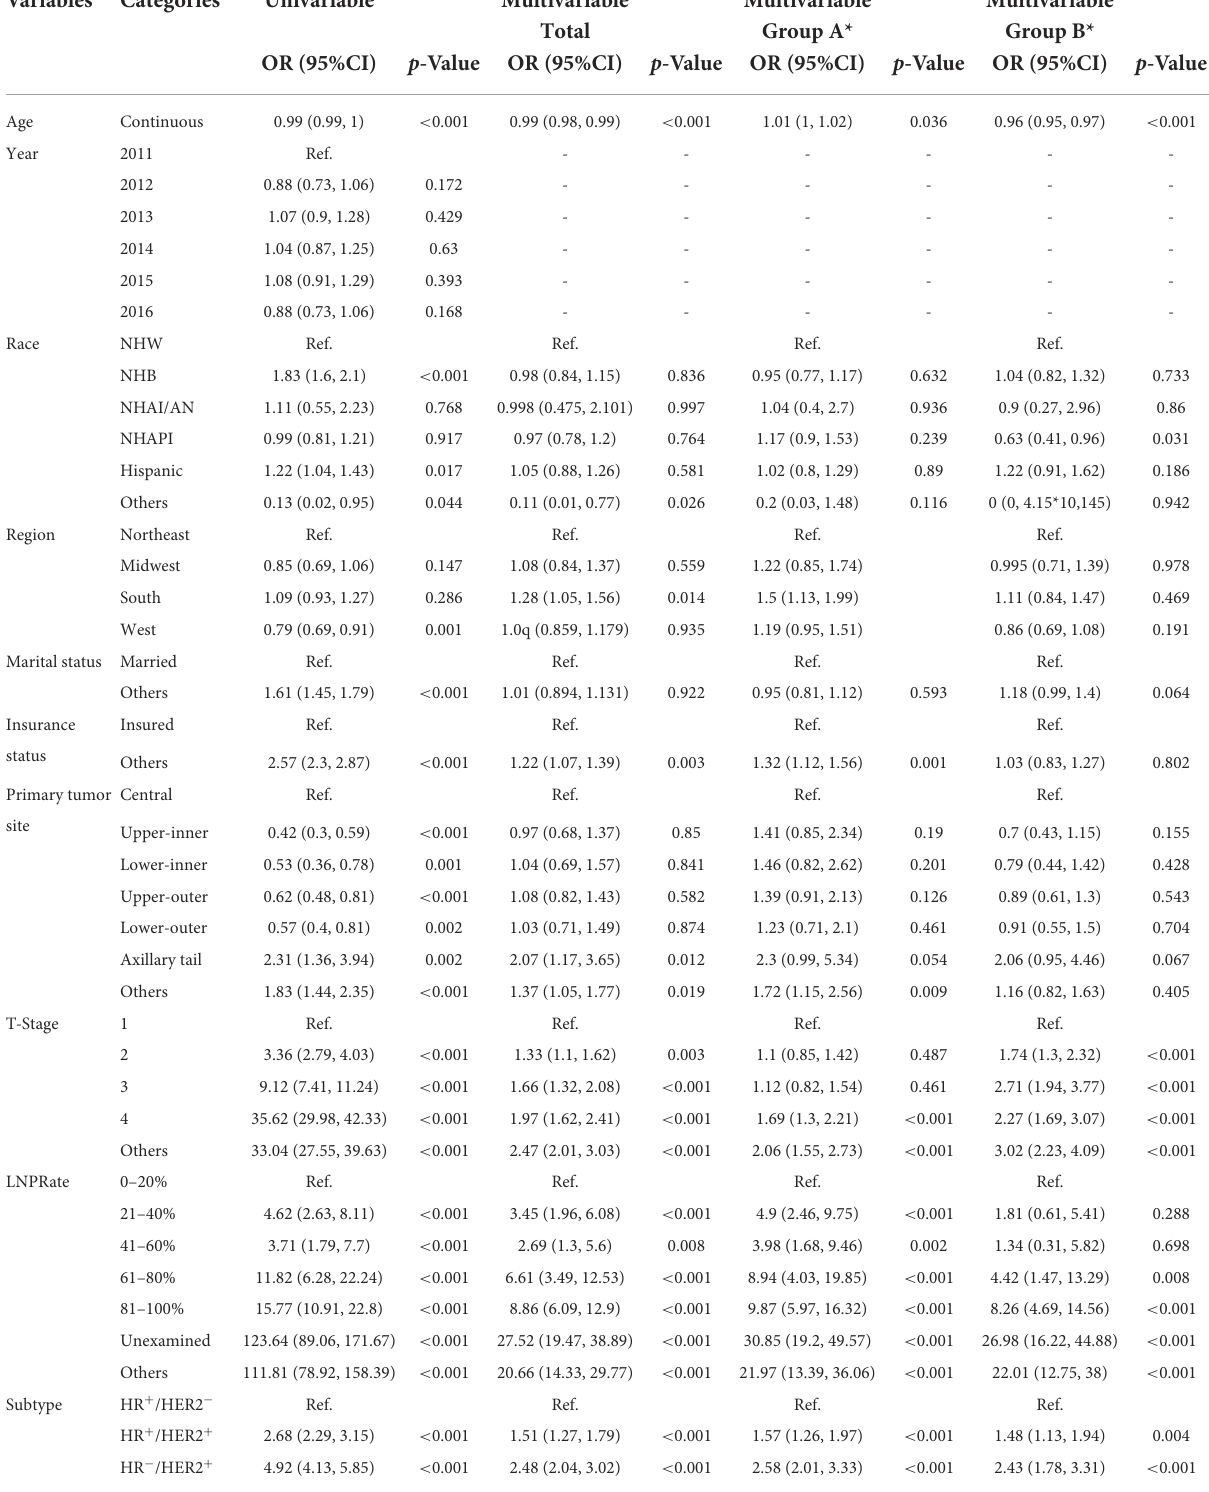
TABLE 2 Univariable and multivariable logistic regression models for the presence of breast cancer synchronous brain metastases.